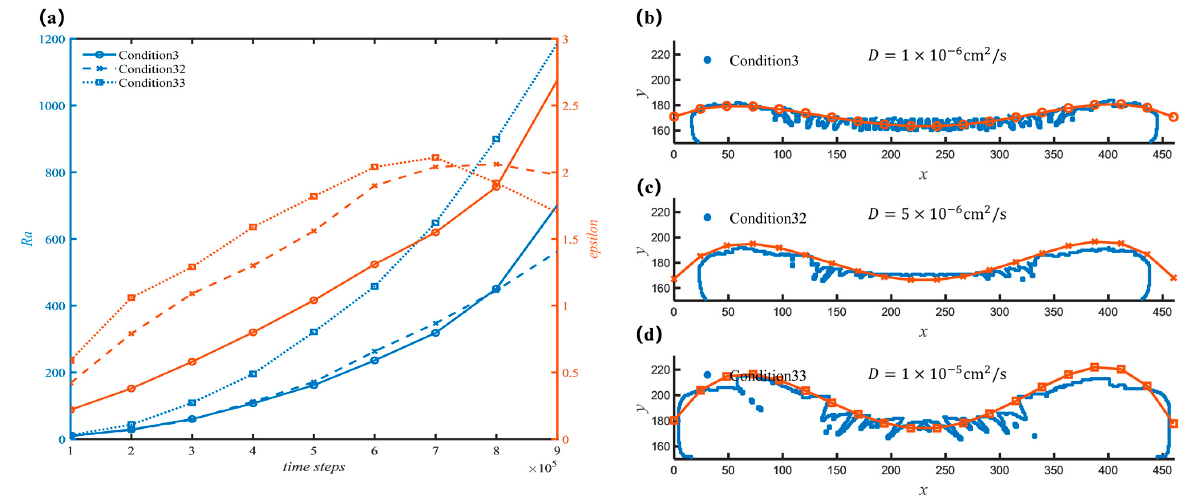
Figure 7. Morphology of sediments with different initial concentration. ( a ) Curves of roughness and overall trend with different working conditions; ( b ) Sediment profile and fit line for condition 14 at 500,000 time steps; ( c ) Sediment profile and fit line for condition 9 at 500,000 time steps; ( d ) Sediment profile and fit line for condition 3 at 500,000 time steps.